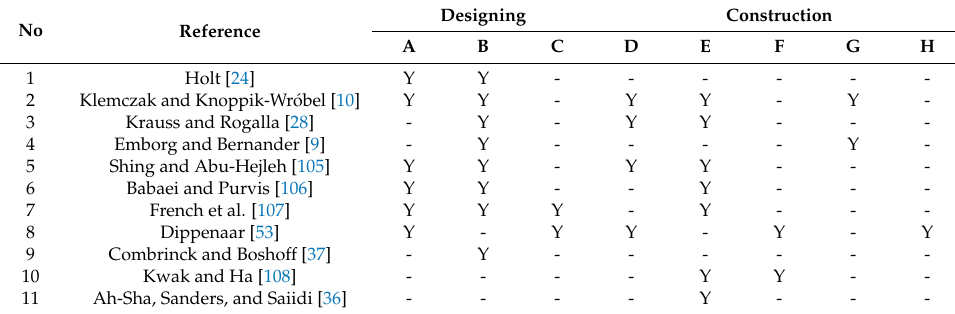
Table 3. Classification of remedial measures to reduce early-age cracking in